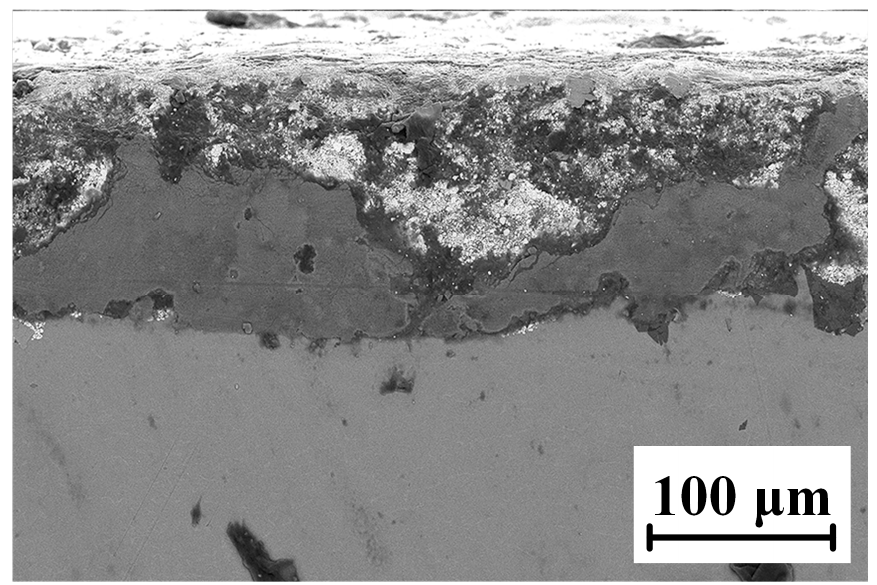
Figure 23. Micro-morphology of the coating cross-section after neutral salt spray corrosion. The surface EDS test results of the WC-12Co coating after 25 days of neutral salt spray corrosion is shown in Figure 24. The content of the bonding phase Co in the WC-12Co coating decreased and there is a large amount of O. The results indicate that the bonding phase Co is preferentially corroded in the salt spray experiment and oxide corrosion product forms. A certain amount of Cl − in the coating is caused by the salt residue on the coating surface in a neutral salt spray environment containing NaCl. From the analysis of the EDS energy spectrum of the coating surface, the bonding phase Co of the WC-12Co coating is preferentially corroded in the neutral salt spray corrosion process. There is a particular potential difference between the WC particles and the bonding phase Co, which in turn generates microcurrent corrosion.